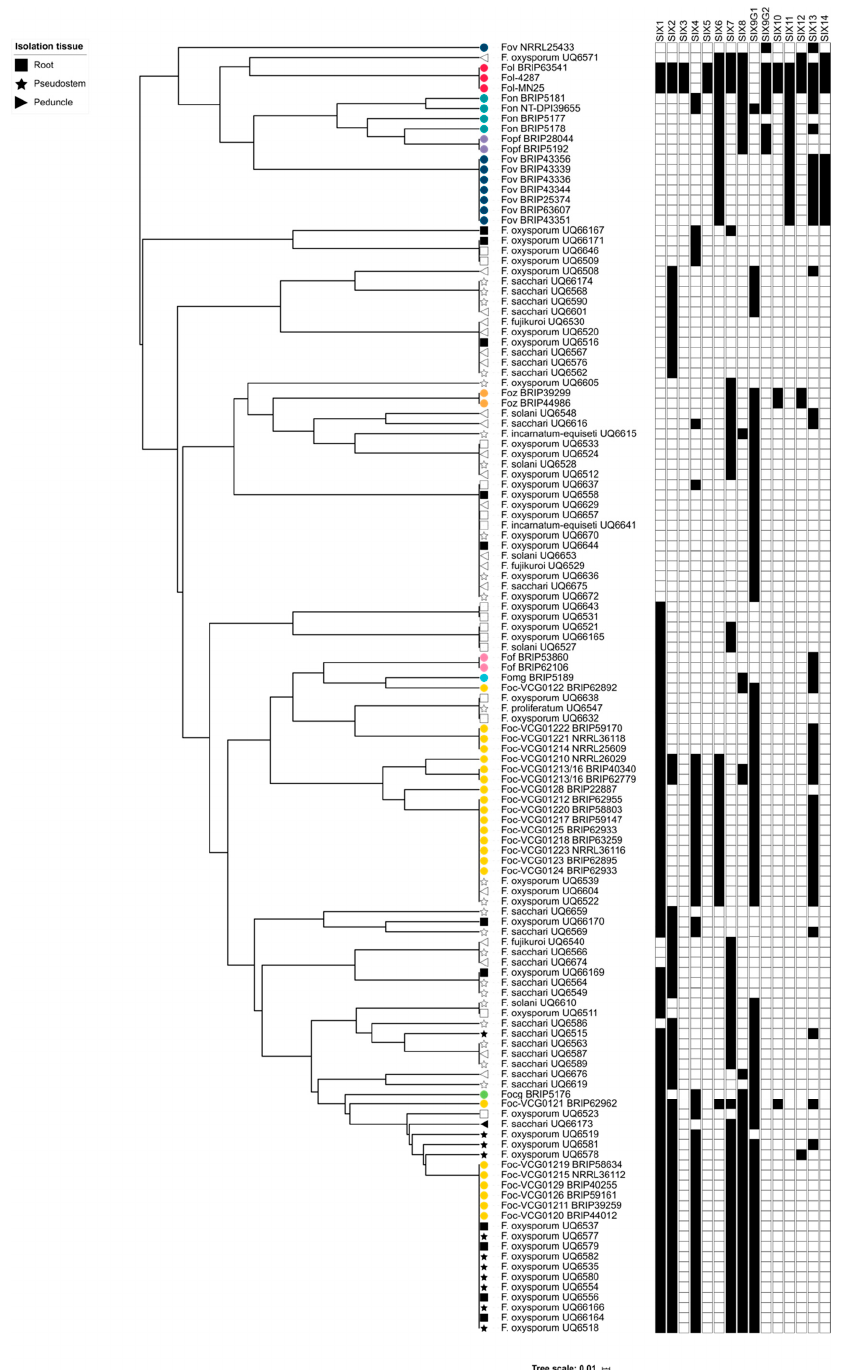
Figure 4. Hierarchical clustering of plant pathogenic formae speciales of F. oxysporum and Fusarium isolated from banana tissue in this study. The secreted in xylem ( SIX ) gene presence/absence matrix used for the cluster analysis is given adjacent to the cluster dendrogram in which a solid block indicates gene presence and a blank block indicates gene absence. Pathogenic formae speciales of F . oxysporum are indicated with a coloured circle. The tissue, from which the Fusarium isolates were recovered, is indicated by either a square (root), star (pseudostem) or triangle (peduncle). Isolates recovered from the Redlands site have a shaded shape. Isolates recovered from the Mullumbimby site have an unshaded